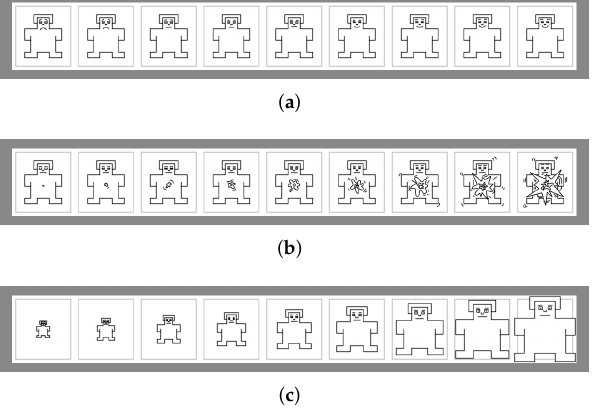
Figure 1. Self-Assessment Manikin (SAM). ( a ) Valence, ( b ) Arousal, ( c )